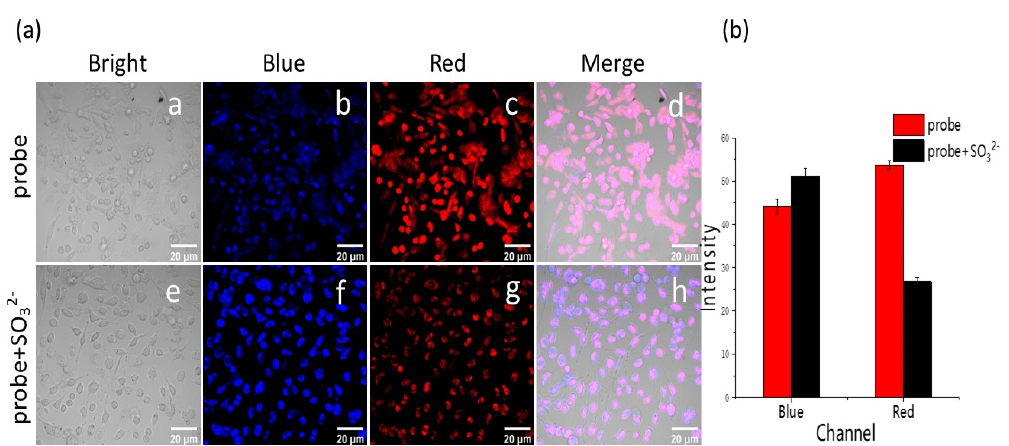
Figure 3. ( a ) Imaging of IPB-RL-1 in SKOV-3 cells. The first row is the imaging of SKOV-3 cells incubated with IPB-RL-1 for 30 min, and the second row is the imaging of SKOV-3 cells incubated with IPB-RL-1 for 30 min and then treated with Na 2 SO 3 for 20 min. ( b ) Comparison of the fluorescence intensity between the red channel and blue channel ( λ ex : 405 nm; blue: λ em = 420–520 nm; red: λ em = 700–800 nm).